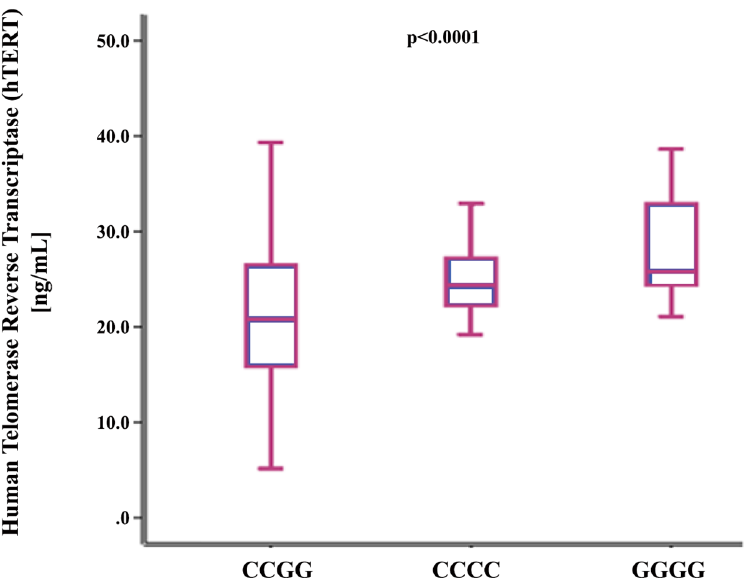
Fig 2. Box plots show the distribution of serum levels of human telomerase reverse transcriptase [hTERT]. The horizontal line within the box corresponds to the median value. Vertical bars represent the values between 2.5 th to 97.5 th percentiles excluding outliers.